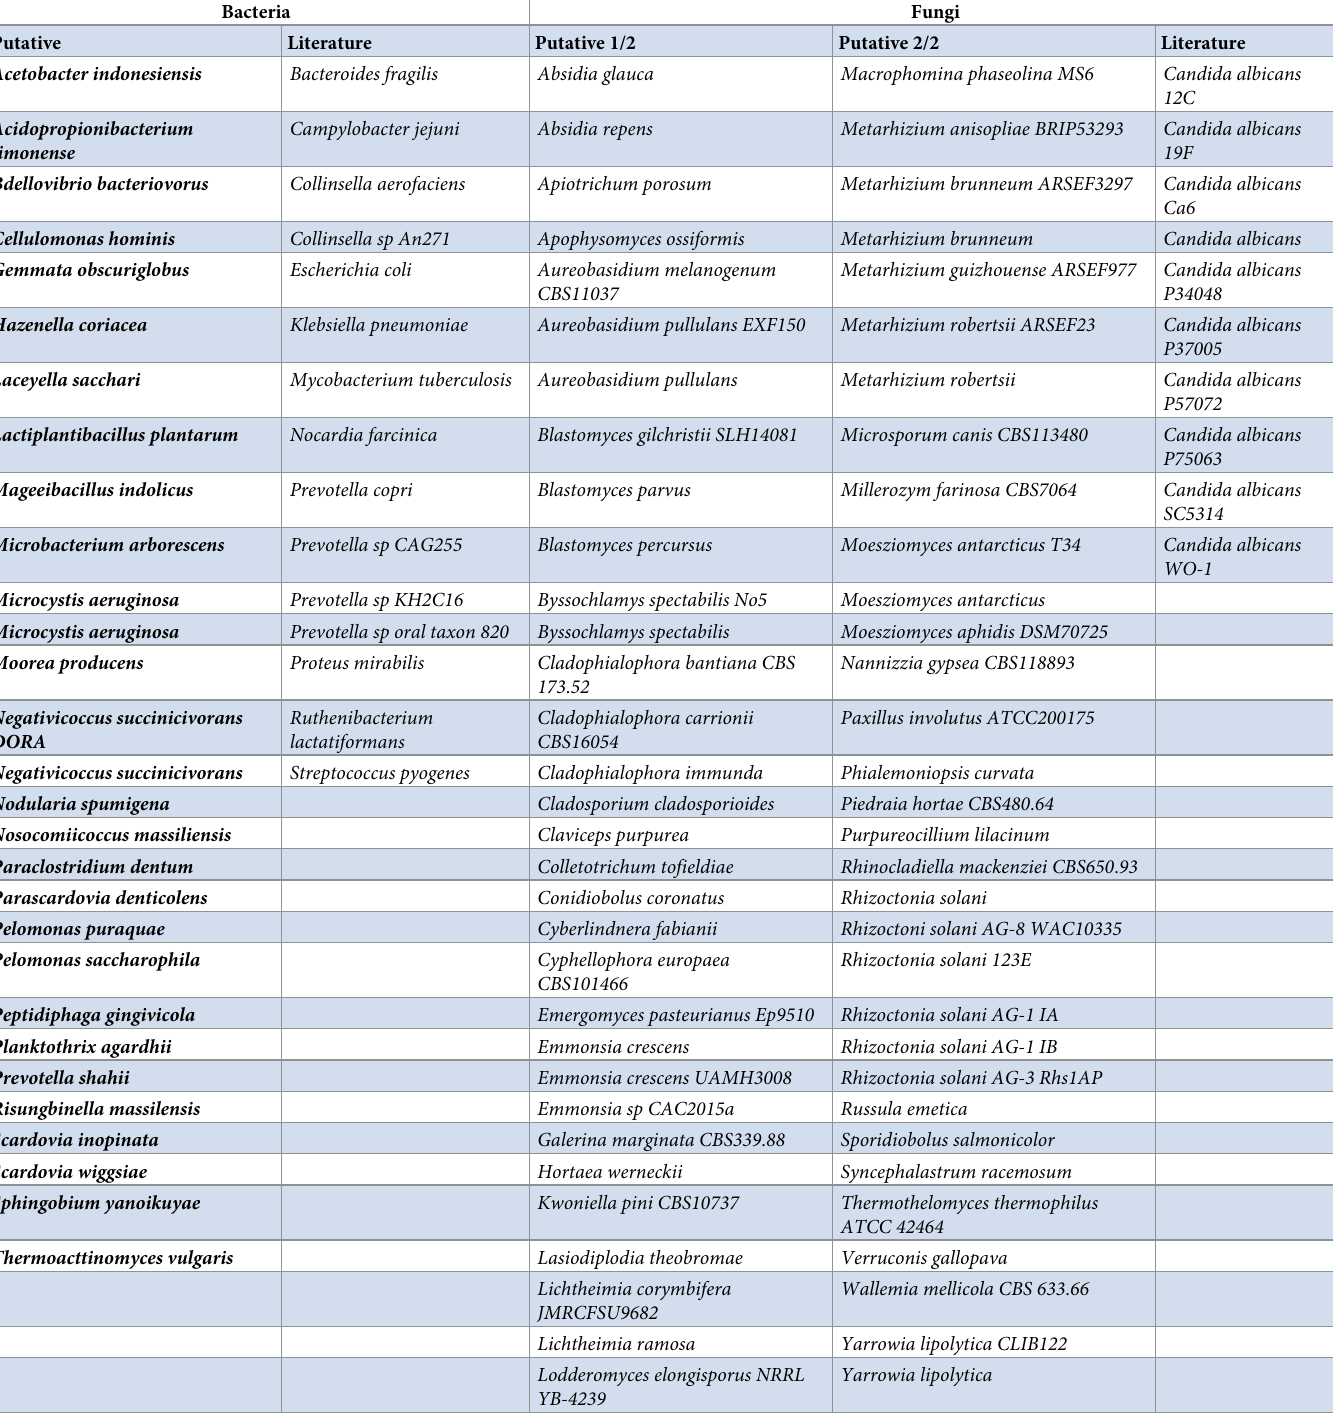
Table 1. A comprehensive list of RA-triggering organisms obtained through presented analysis, comprising both the organisms previously related to RA (con- firmed examples from the Literature) and novel candidates.